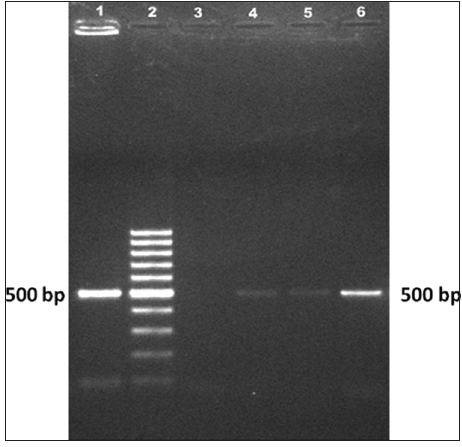
Figure-1: 1.5% agarose gel stained with ethidium bromide showing amplification of 500 bp fragment ( Mycobacterium bovis specific) from positive milk samples indicating the presence of M. bovis. Lane 1: M. bovis AN5 (positive control); Lane 2. 100 bp Marker; Lane 3. Negative control; Lane 4. ND/1639; Lane 5. ND/1935; Lane 6. ND/1754.